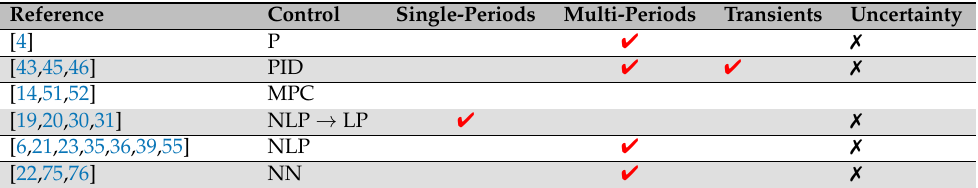
Table 5. Comparison of the